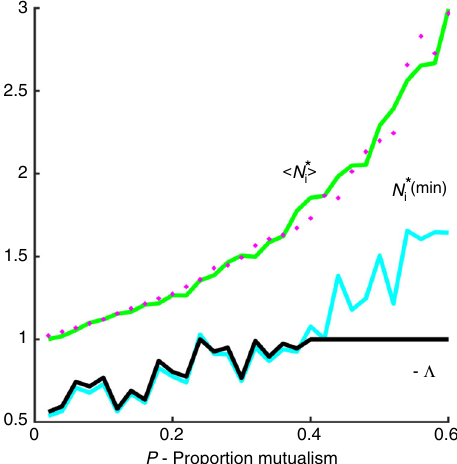
Fig. 4 Equilibrium populations. The critical eigenvalue Λ (black line) is plotted as a function of P , the proportion of mutualists. The minimum equilibrium value (cid:2) N * of the populations (blue line) is a good min approximation to the critical eigenvalue Λ in the regime N * 1. Outside of min < this regime Λ ¼ (cid:2) 1. Plotted in green is h N * i which should be a proxy for the i magnitude of the bulk eigenvalues (Eq. (3)). The magenta circles plot the ≃ 1 = ½ 1 (cid:2) n (cid:2) 1 ð Þ mCP (cid:4) . Parameters, as in Figs. 2 and 3: approximation N * i